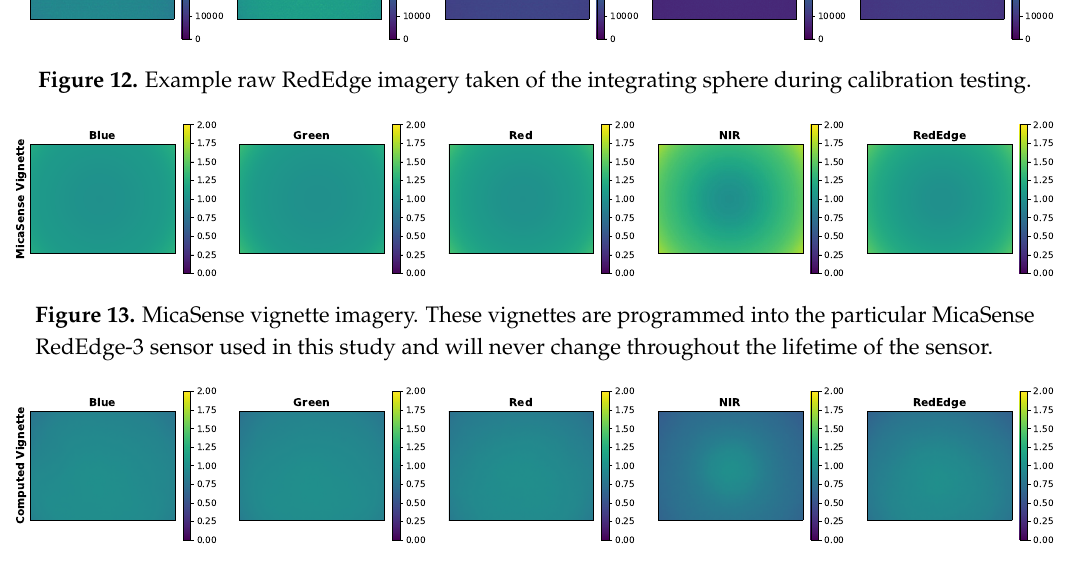
Figure 14. Example proposed vignettes. These vignettes are computed with the methodology proposed in this paper, for the particular light level, gain and exposure time combination (One Lamp 50% closed, Gain 2 × and 0.698 ms).